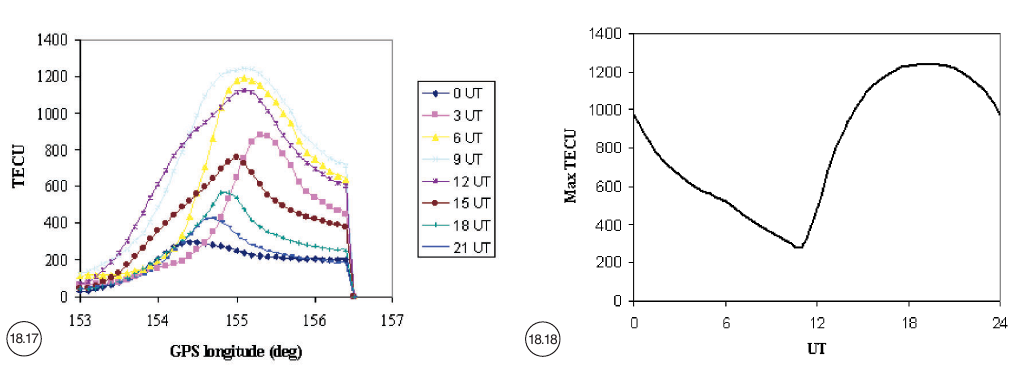
Fig. 18.17. TEC from GPS satellite to a Geostationary satellite located at 0° longitude with ray-path geometry near eclipse. Both satellite in the equatorial plane. Fig. 18.18. Maximum TEC versus UT for a path from GPS satellite at a longitude of 205° E to a Geostationary satellite at a longitude of 0°.